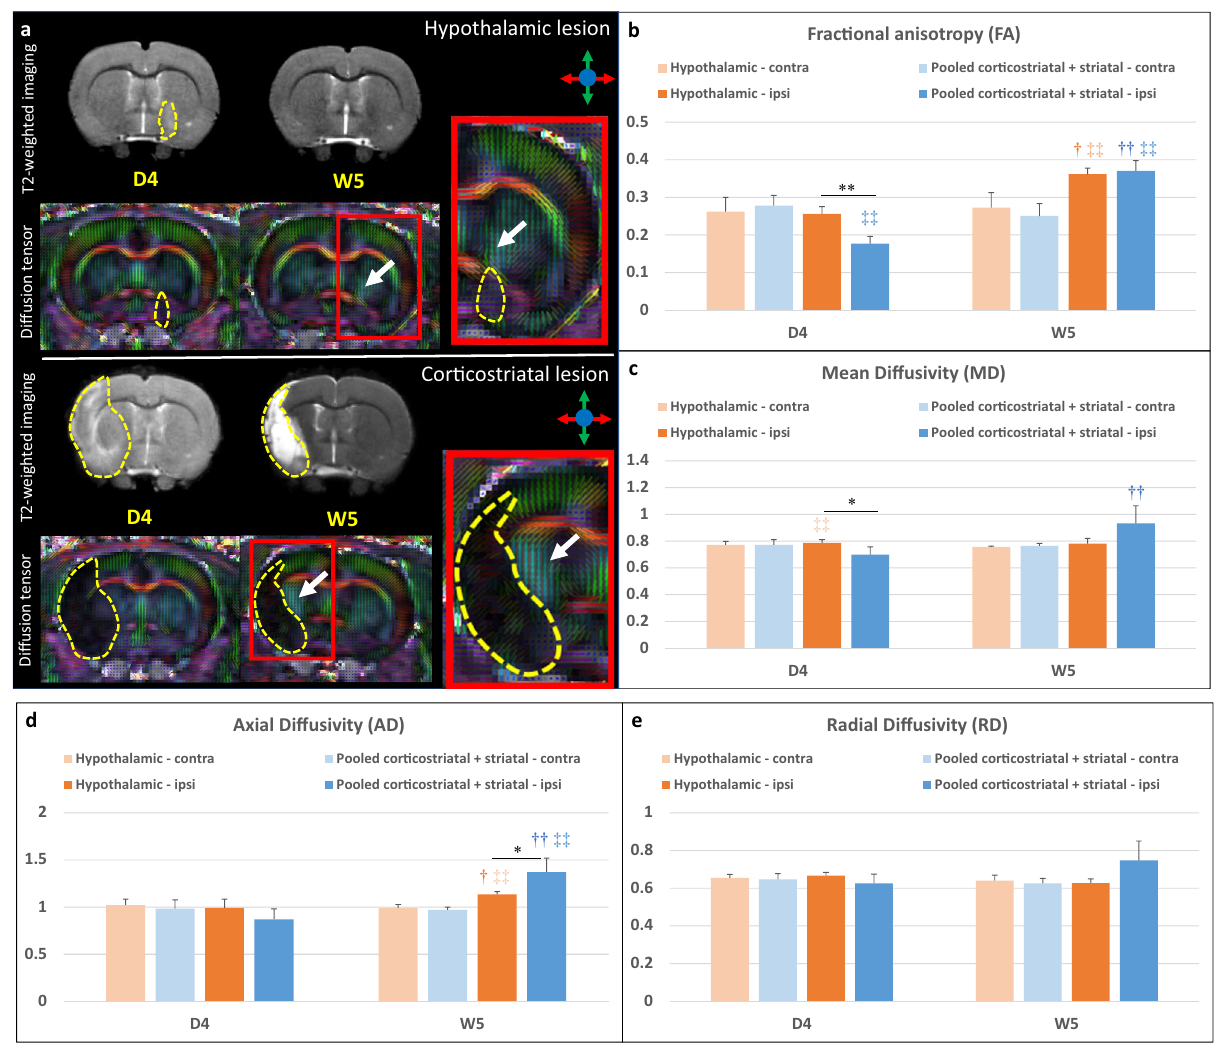
Figure 4. DTI readouts. ( a ) Example of T2-weighted imaging and color-coded fractional anisotropy for two individual rats: one with a hypothalamic lesion and one with a corticostriatal lesion (dotted yellow line). Only the central slice is presented. The internal capsule is pointed out by the white arrow. ( b–e ) Average DTI metrics (respectively FA, MD, AD and RD) are presented according to lesion subtype: pooled (corticostriatal + striatal) vs. hypothalamic lesions at day 4 (D4) and week 5 (W5) post-surgery. FA fractional anisotropy, MD mean diffusivity, AD axial diffusivity, RD radial diffusivity. *p < 0.05, **p < 0.01, (corticostriatal + striatal) vs. hypothalamic, Wilcoxon–Mann–Whitney test; † p < 0.05, †† p < 0.01, W5 vs. D4, Friedman test; ‡ p < 0.05, ‡‡ p < 0.01, ipsilateral (ipsi) vs. contralateral (contra) side, Friedman